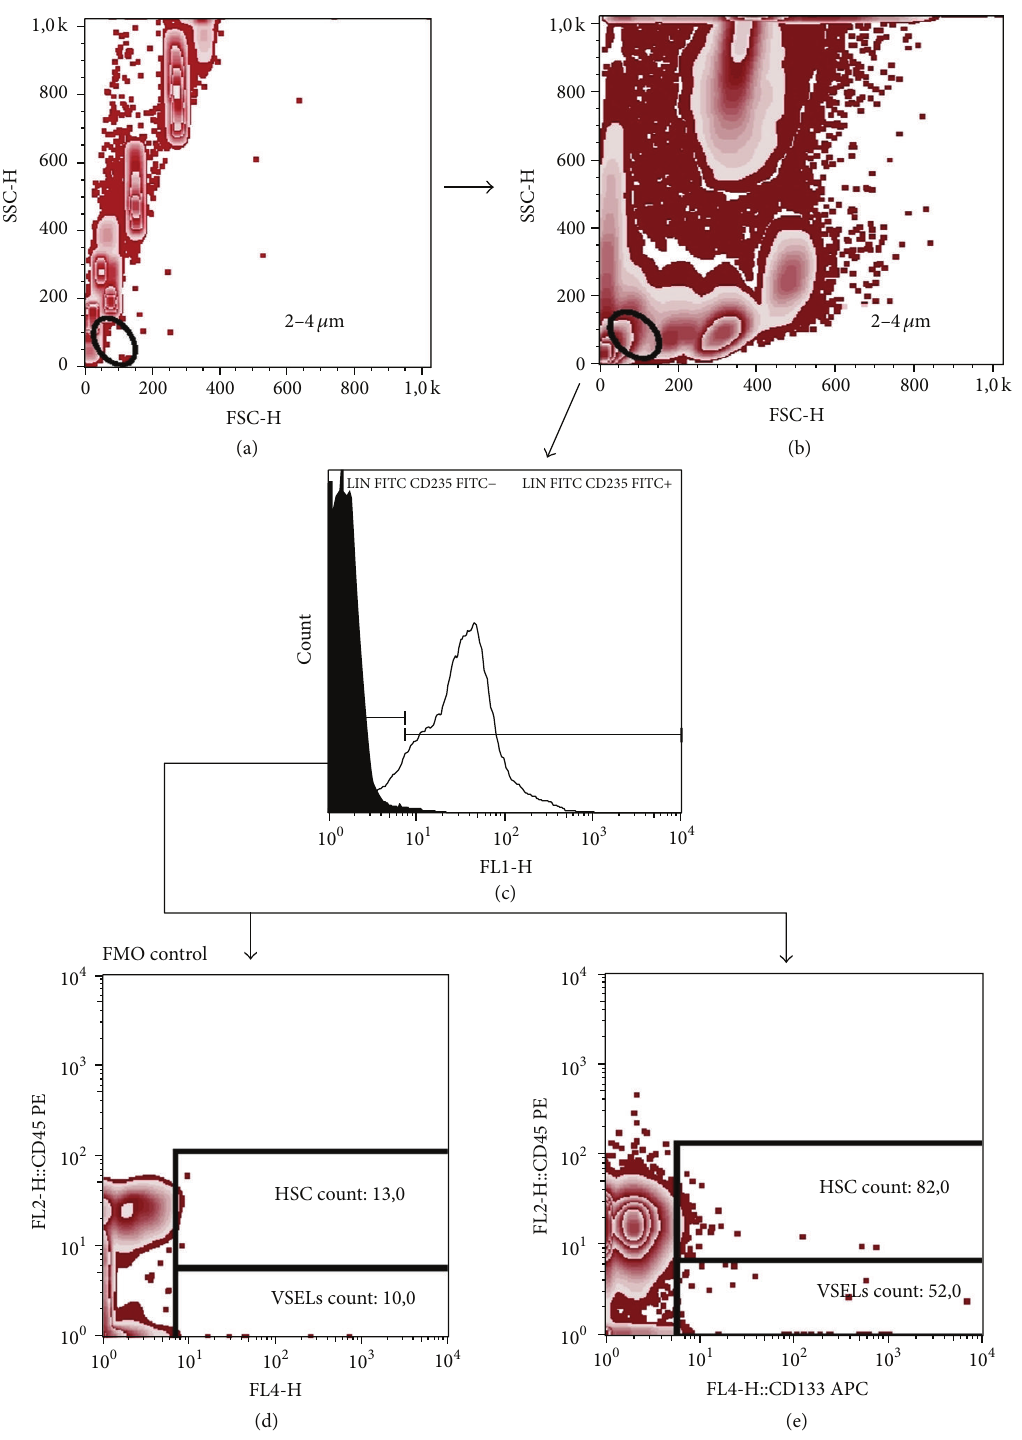
Figure 1: Representative FACS plots demonstrating gating strategy for HSC and VSELs. First, 2–4 𝜇 m size events were gated based on a forward and side scatter (FSC/SSC) dot plot (a). Then the 2–4 𝜇 m gate was visualized on sample data using a FSC/SSC dot plot (b). Next, 2–4 𝜇 m events were displayed on histogram plot (black peak, FMO control; grey peak identifies positive staining) and Lin − CD235a − events were gated (c). Finally, FMO control was used to set the HSC and VSELs gate and exclude the background noise (d). Next, HSCs were defined as Lin − CD235a − CD45 + CD133 + cells (upper gate) and VSELs were referred to as Lin − CD235a − CD45 − CD133 + cells